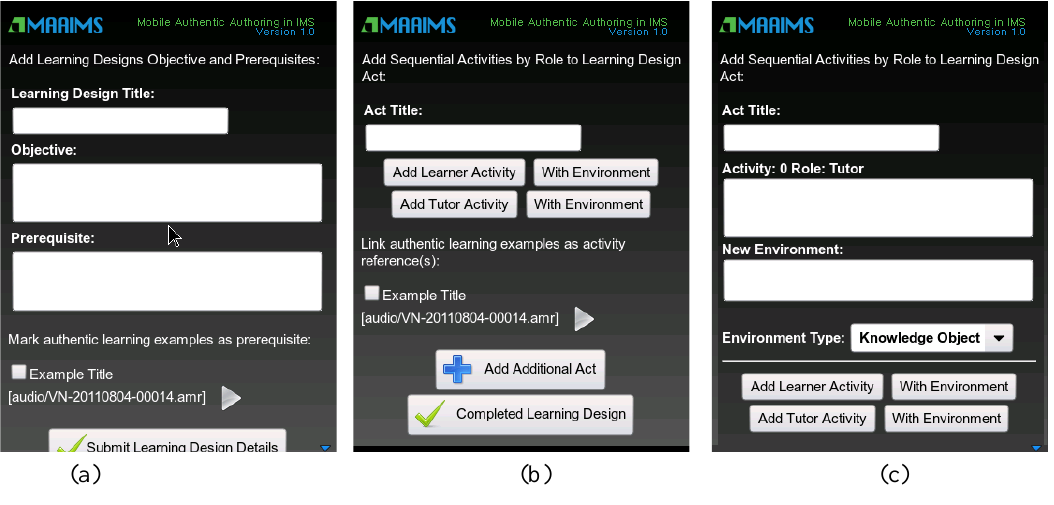
Figure 4 . Learning Design objectives and prerequisites are created in (a), (b) shows new activities created within acts, and authentic learning examples tagged as references, and (c) displays activities created with an